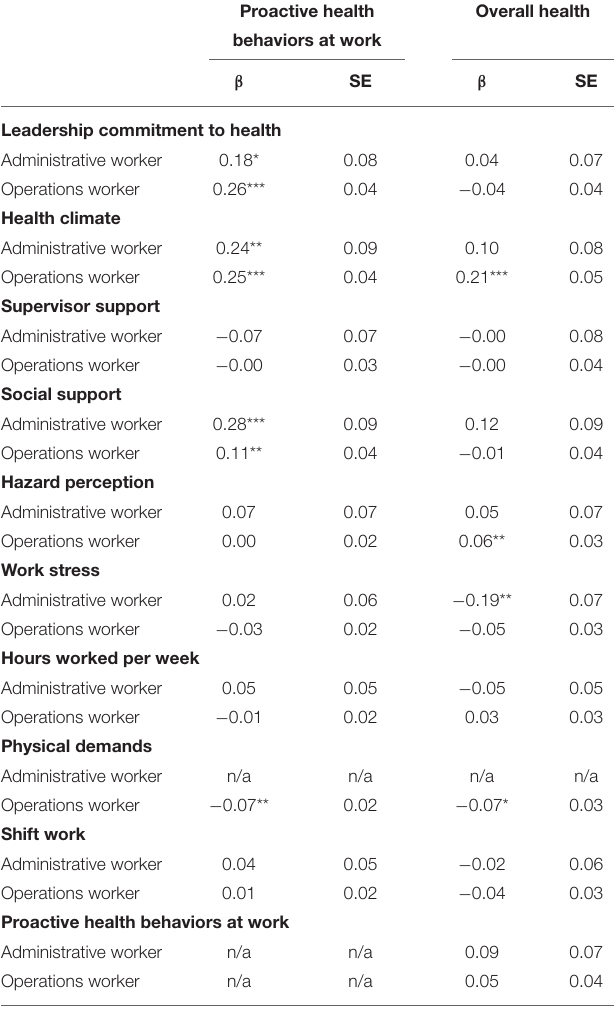
TABLE 4 | Path analysis results by type of